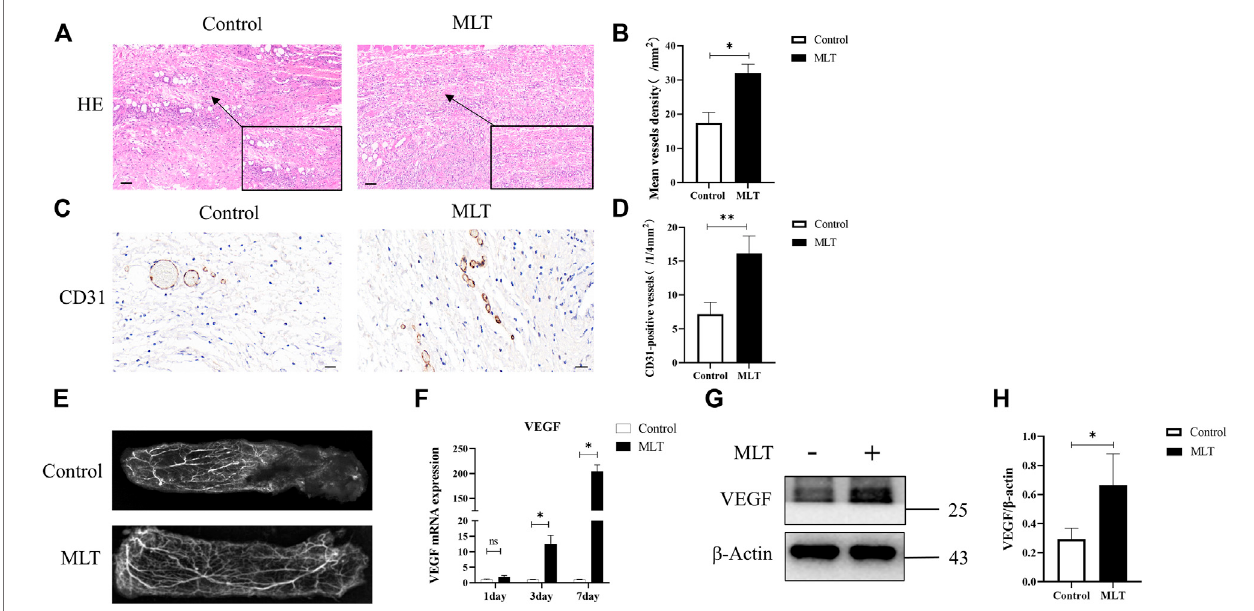
FIGURE2| MLTpromotedangiogenesisofskin fl ap. (A) H&Estainingshowsskin fl apangiogenesisonpostoperativeday7(originalmagni fi cation×200).Scalebar: 50 μ m. (B) The MVD per unit area assessed by H&E staining. Signi fi cant differences between the groups are indicated by * p < 0.05. (C) Immunochemical detection